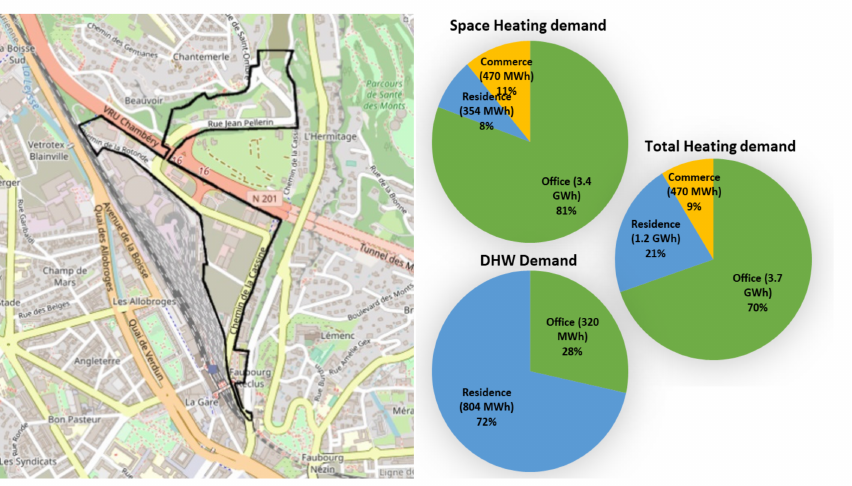
Figure 1. Boundary mapping (© OpenStreetMap contributors - licensed under the Open Data Commons Open Database License–OdbL-by the OpenStreetMap Foundation-OSMF)and distribution of annual space heating and DHW demands of the Cassine district located in Chamb é ry,